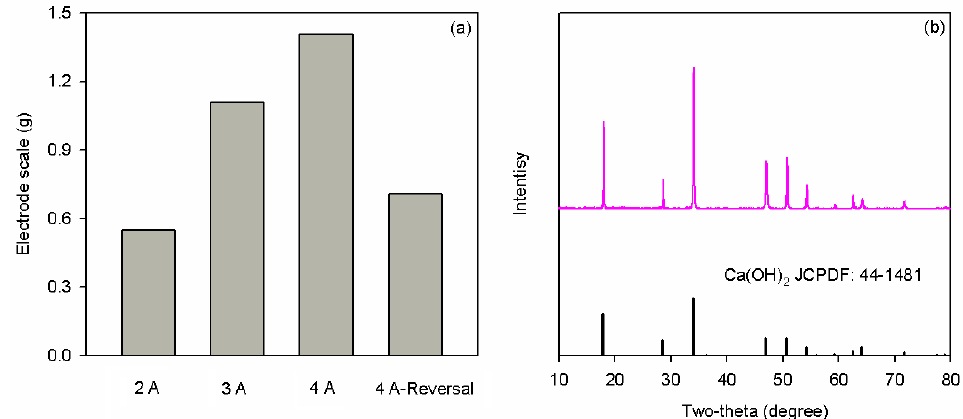
Figure 5. ( a ) The amount and ( b ) XRD analysis of electrode scale during the electrochemistry treatment of the spent caustic wastewater.